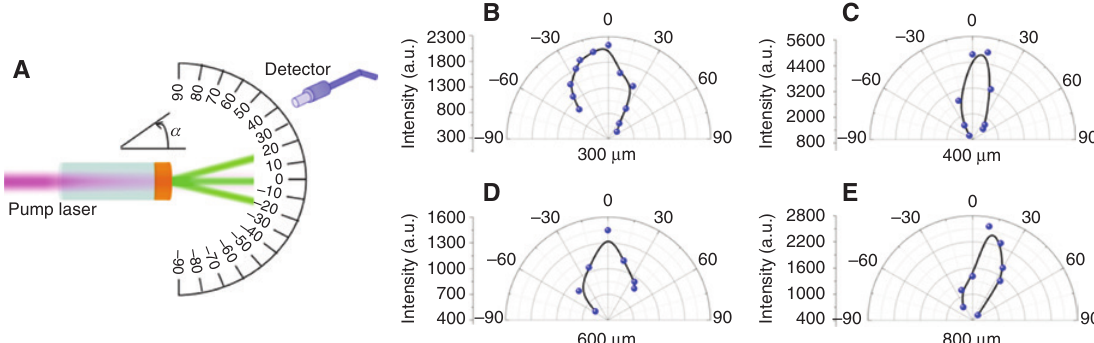
Figure 5: Directionality of a perovskite random laser emission. (A) Schematic of the intensity measurement at different angles. The intensity of the output laser as a function of the angle for fibers with diameters of (B) 300, (C) 400, (D) 600, and (E) 800 μ m.